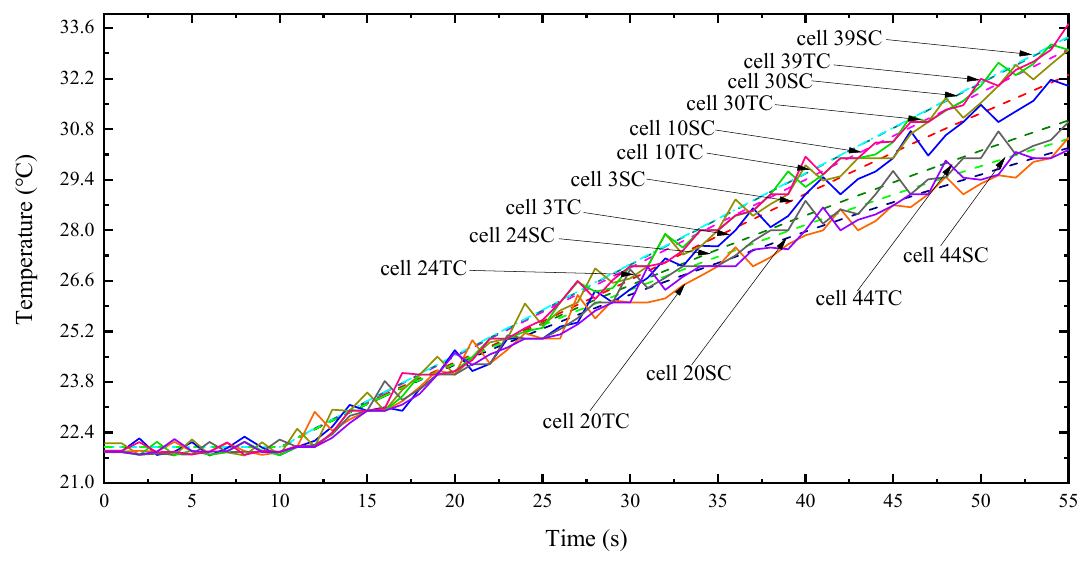
Figure 12. Comparison curve between experiment and simulation.